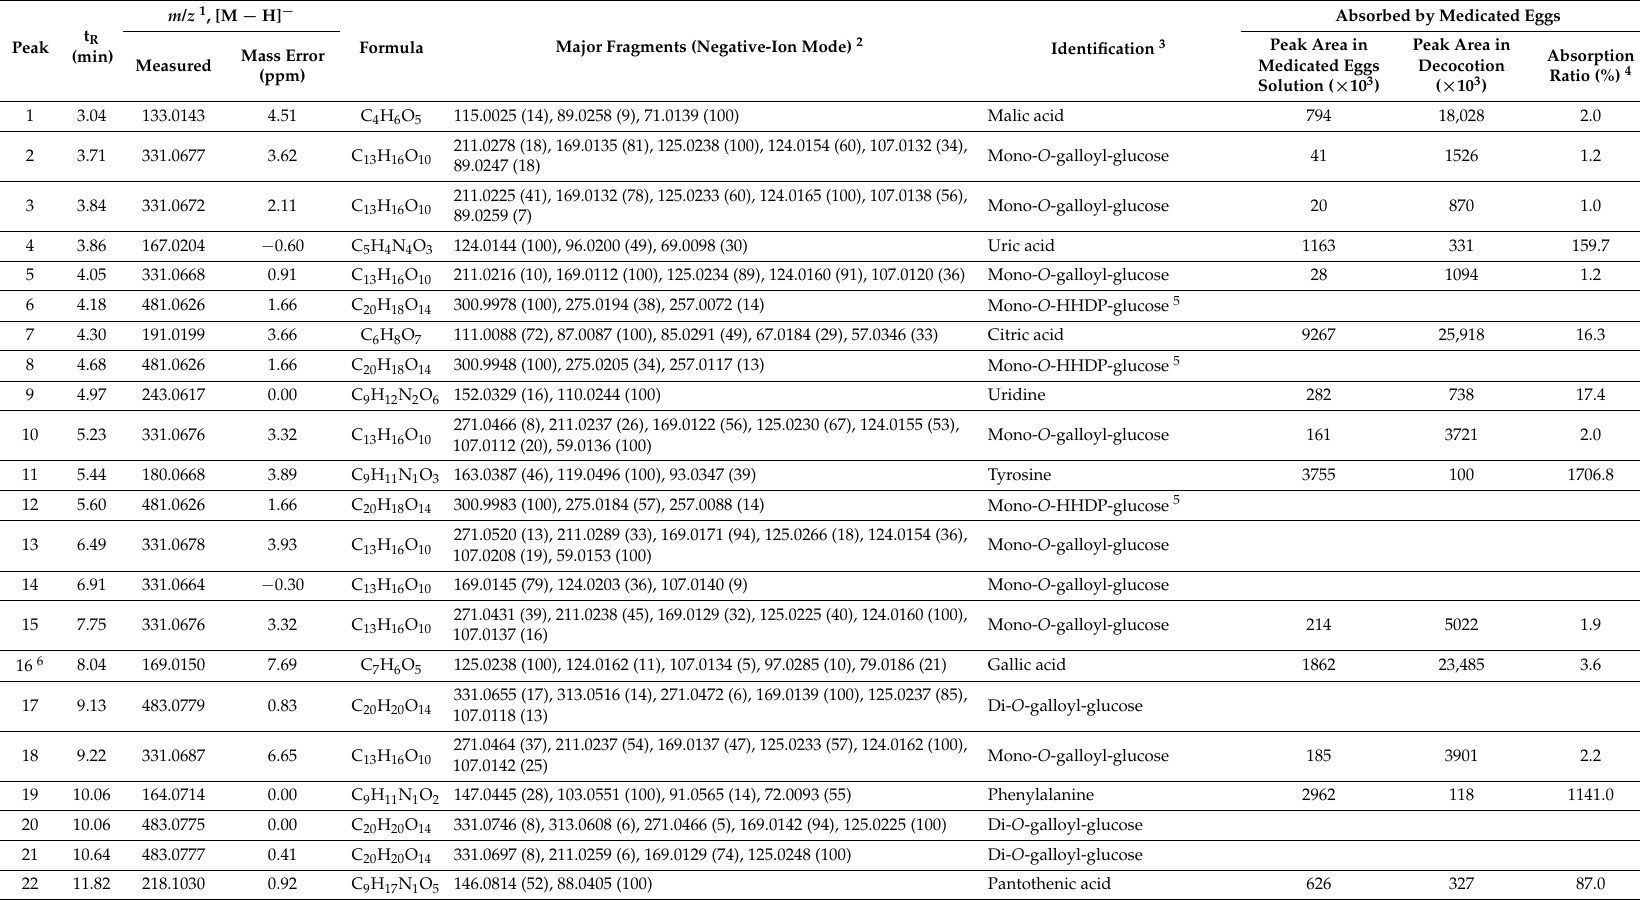
Table 1. Constituents tentatively identified in Juglans mandshurica decoction and those absorbed by medicated eggs using HPLC-Q-TOF-MS 2